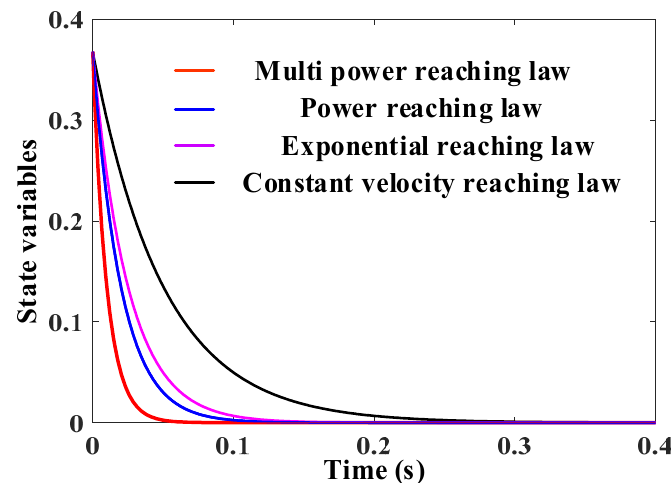
Figure 13. State variables at various reaching laws.